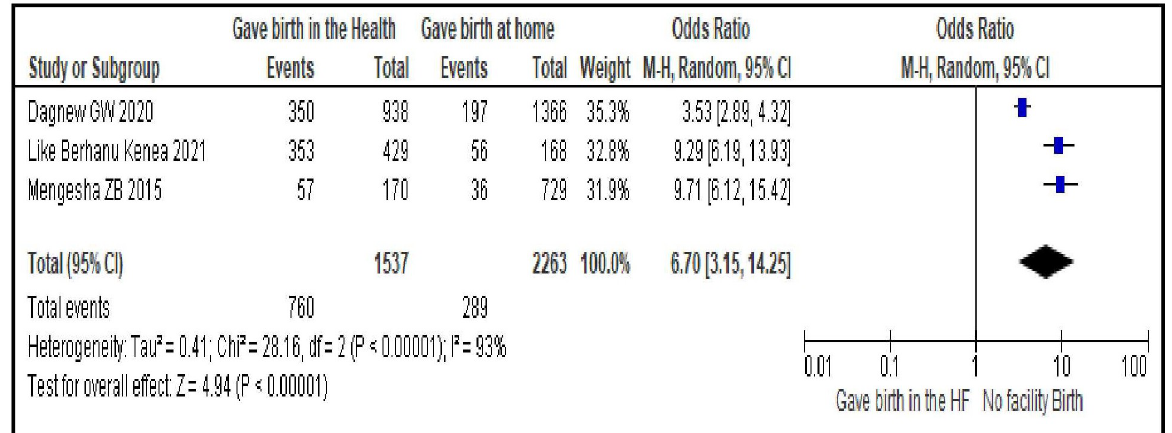
Fig 10. Association between giving birth in the facility and modern contraceptive uptake during postpartum period, 2021.